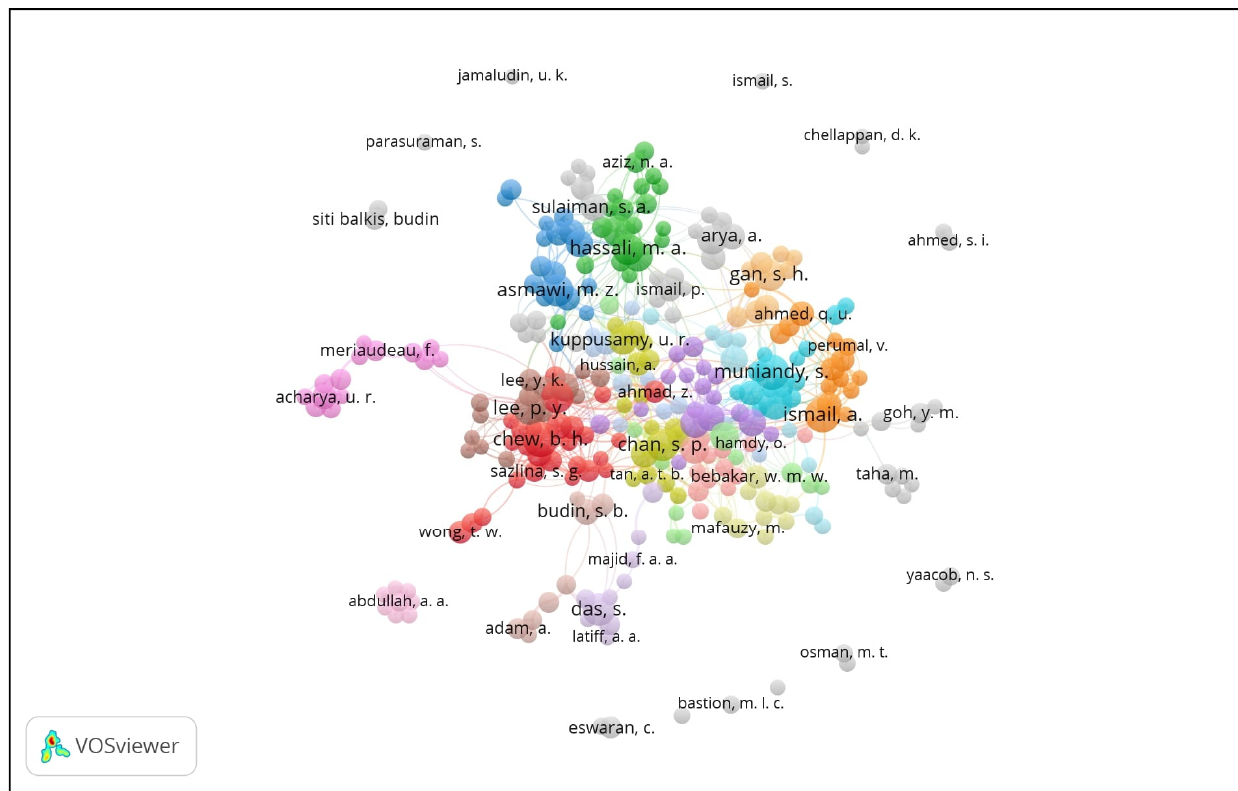
Figure 7. Radar chart showing the network of co-authorships of the diabetes research output. Note: The threshold was set at ≥ 5 publications. The size of the circle represents the density of the output productivity, while the thickness of the connecting lines represents the collaboration strength.